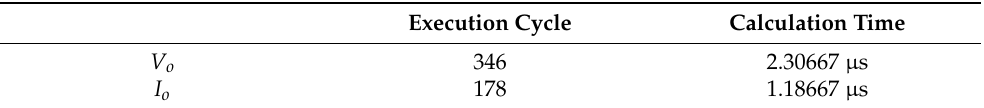
Table 5. Calculation time for I o and V o (TMS320F28335 150 MHz).